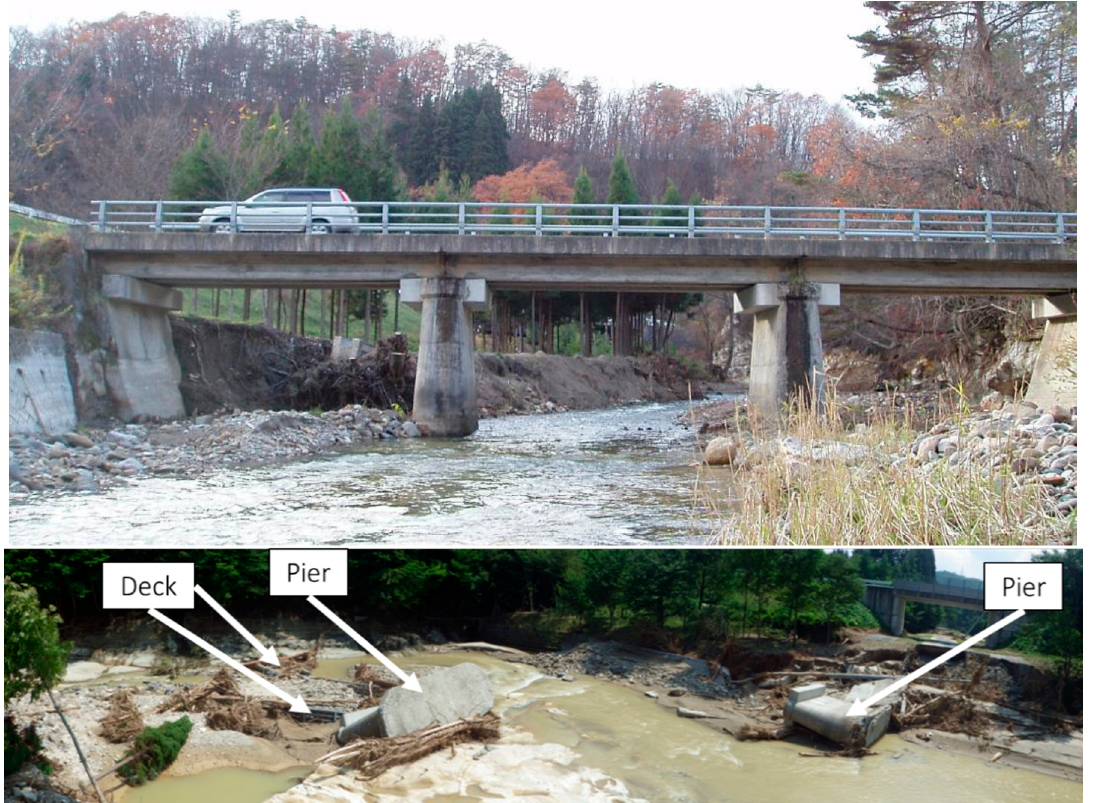
Figure 3. Yabitsu bridge before flood ( upper ) and after ( lower ).